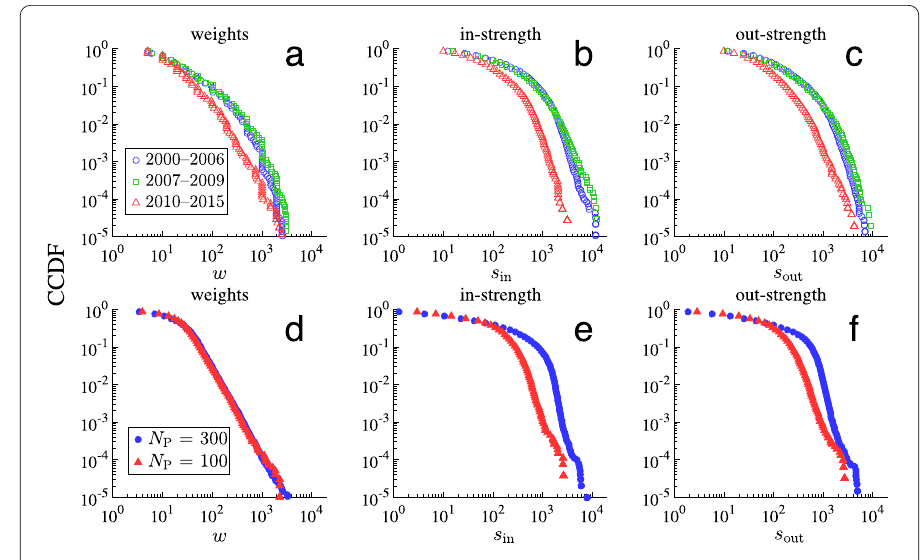
(cid:2) j (cid:16) = i w ji